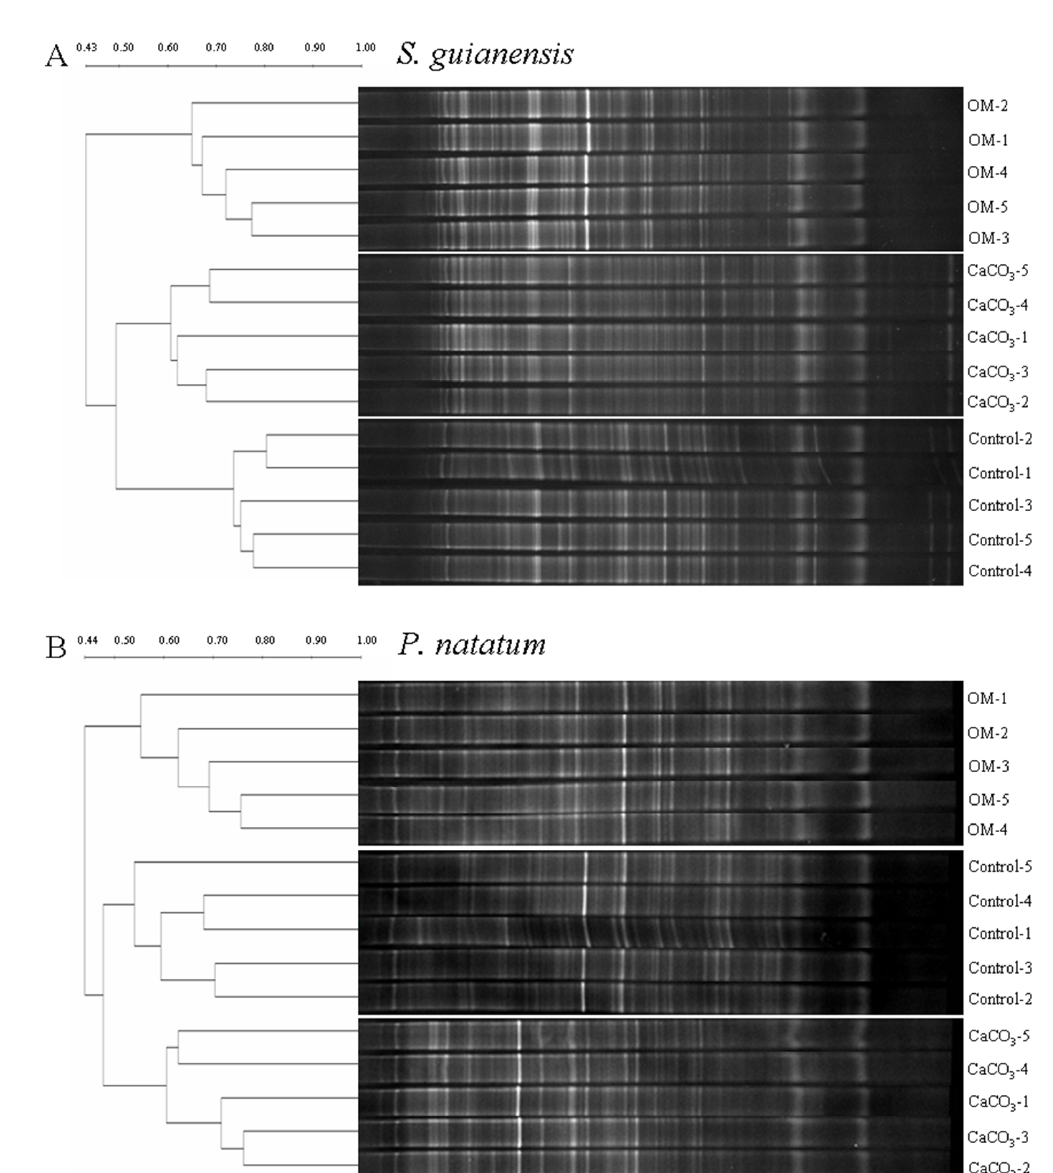
Figure 2. Denaturing Gradient Gel Electrophoresis profiles of the bacterial community in the rhizosphere of S. guianensis ( A ) and P. natatum ( B ) and the corresponding clustering analysis. CaCO 3 , liming; OM, plant residue incorporation.